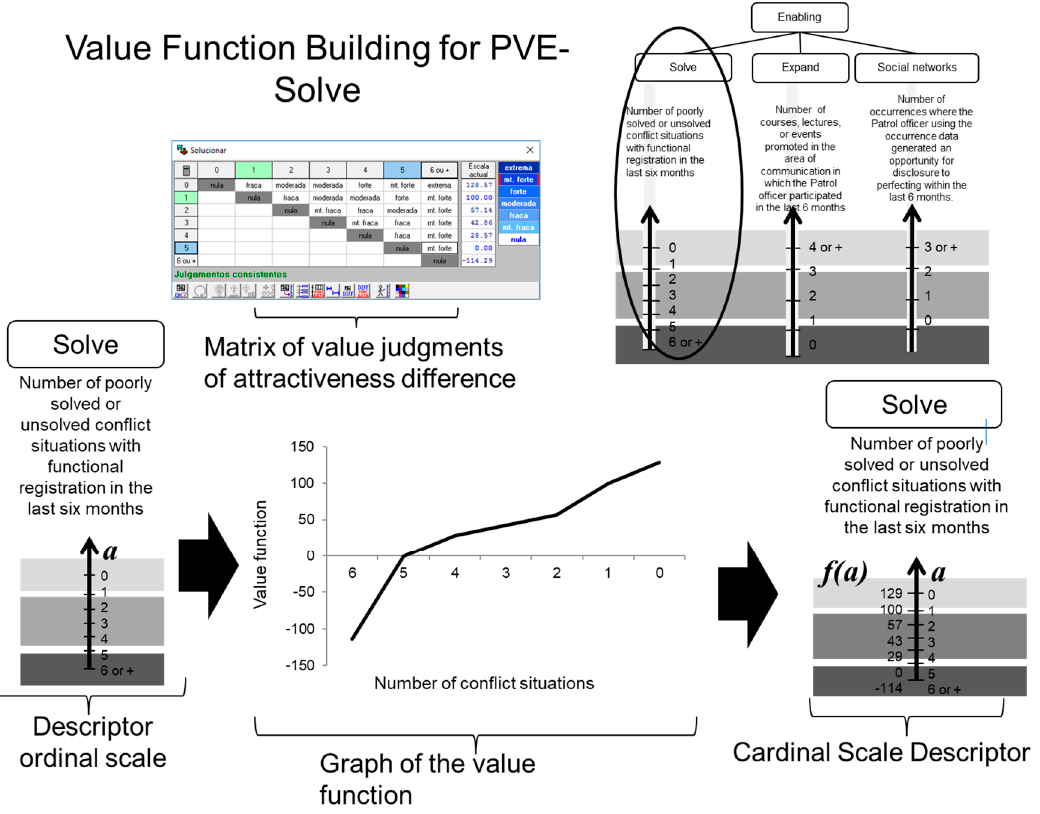
Figure 3. Transforming the descriptor, solve, into a value function, using the MACBETH method.